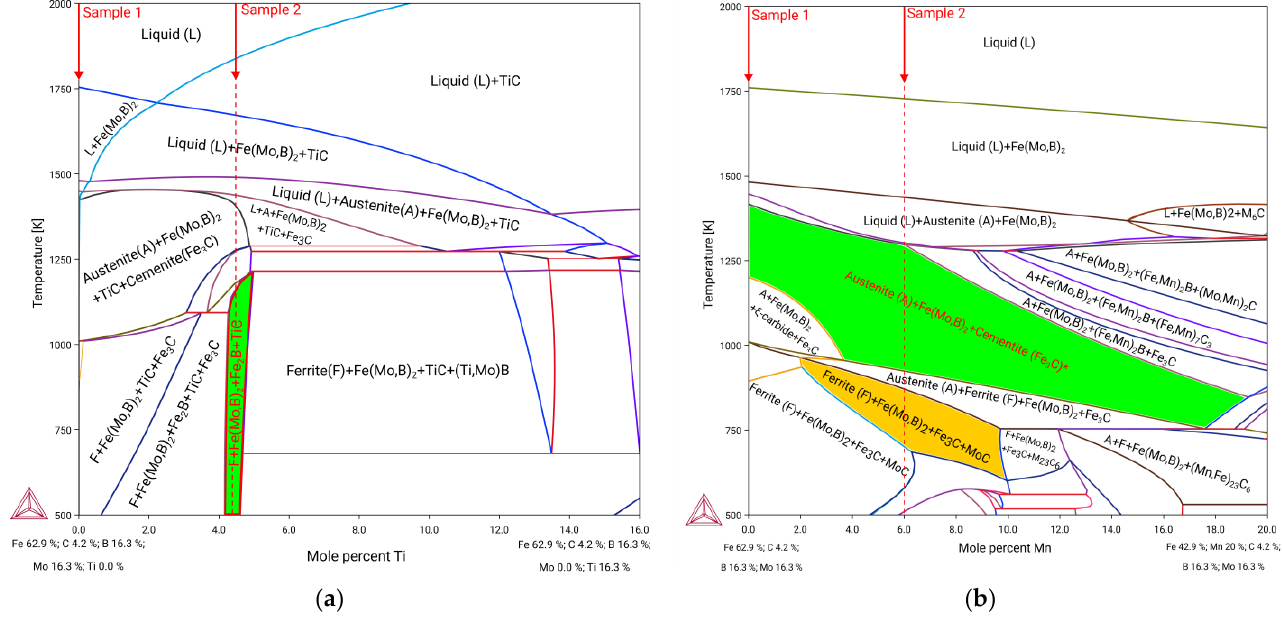
Figure 5. The polythermal sections of the Fe-Mo-Ti-B-C ( a ) and Fe-Mo-Ti-B-C ( b ) systems. The temperature dependencies of the phase composition during solidification for the alloys corresponding to the experimental hardfacing alloys are shown in Figure 6a – c. The solidification of the base alloy (Sample 1) starts at a temperature of about 1750 K (Figure 6a) from the crystallization of the Fe(Mo,B) 2 phase, and after increasing its amount up to 0.3 volume fraction at 1500 K, eutectic decomposition of the liquid into a mixture of austenite and Fe(Mo,B) 2 takes place, and further cooling in the range of 1500 to 1000 K leads to the precipitation of the cementite phase. After the eutectoid reaction of the austenite decomposition into Ferrite and Cemenite occurs, the resulting predicted structure consists of primary Fe(Mo,B) 2 , eutectic Fe(Mo,B) 2 + Austenite, and the Pearlite-like eutectoid. The solidification process of Sample 3 is very similar to the base alloy (Sample 1) except for the broader temperature ranges of eutectic and eutectoid reactions and lower cementite stability (Figure 6c). The solidification of the alloy, according to Sample 3, starts with the formation of the Ti carbide at a temperature of about 1800 K, then the Fe(Mo,B) 2 phase crystallizes, and the amount of both phases increases simultaneously during cooling. At 1500 K, the eutectic (Fe(Mo,B) 2 + Austenite) reaction occurs and the complex eutectoid-like reaction including Fe(Mo,B) 2 , Austenite, Fe 2 B, and TiC takes place at 1250 K. The resulting structure thus consists of four phases (Ferrite, Fe(Mo,B) 2 , Fe 2 B, and TiC), forming primary phases (carbide and boride), eutectic and eutectoid. The main differences between the phase composition of the alloy solidified under real conditions and the equilibrium state are characteristic of austenitic systems with high levels of dissolved Mn, similar to the composition of Sample 3. This is caused by a strong austenite-stabilizing effect of Mn, which prevents eutectoid decomposition of austenite into a ferrite–cementite mixture. Thus, the structure of the real alloys cast under normal conditions corresponds to high- temperature regions (above 1000 K) of the phase diagram and the equilibrium structure can be obtained through the long annealing that provides high intensity of the